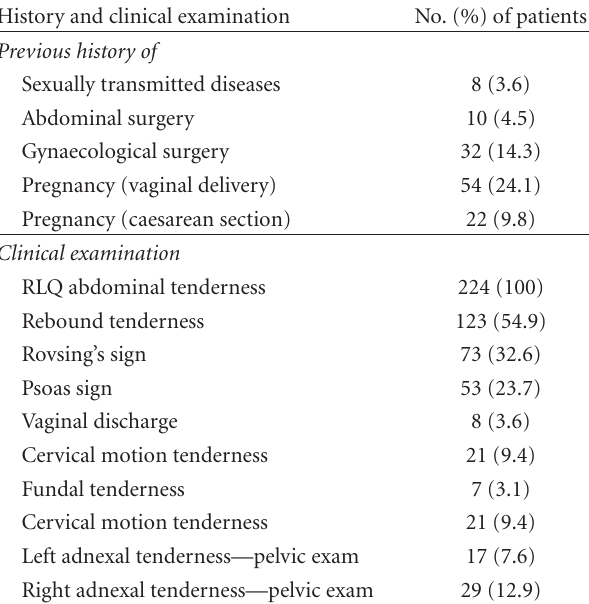
Table 1: Study population clinical